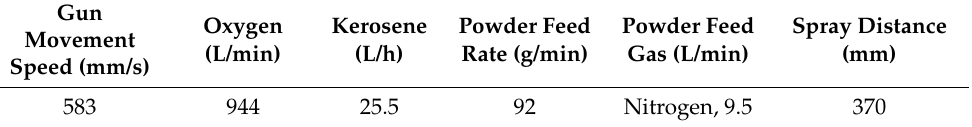
Table 2. HVOF spraying